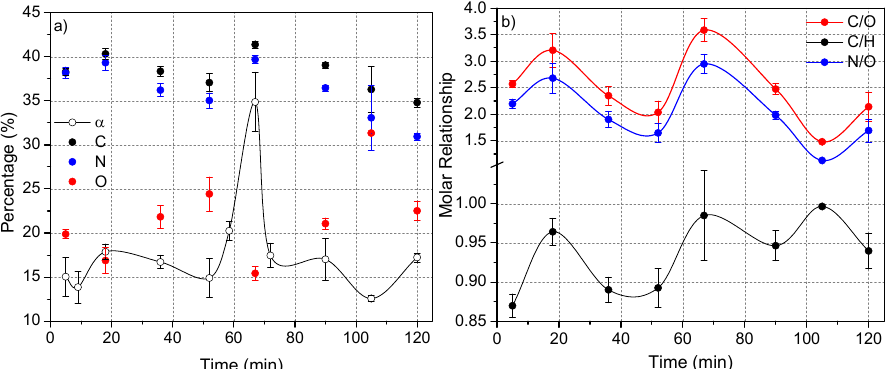
Figure 11. Evolution of the polymerization of NH 4 CN with the time at 170 °C. ( a ) Variation of the conversion degree, α (%), and the elemental composition of the cyanide polymers; ( b ) variation of the molar relationships.